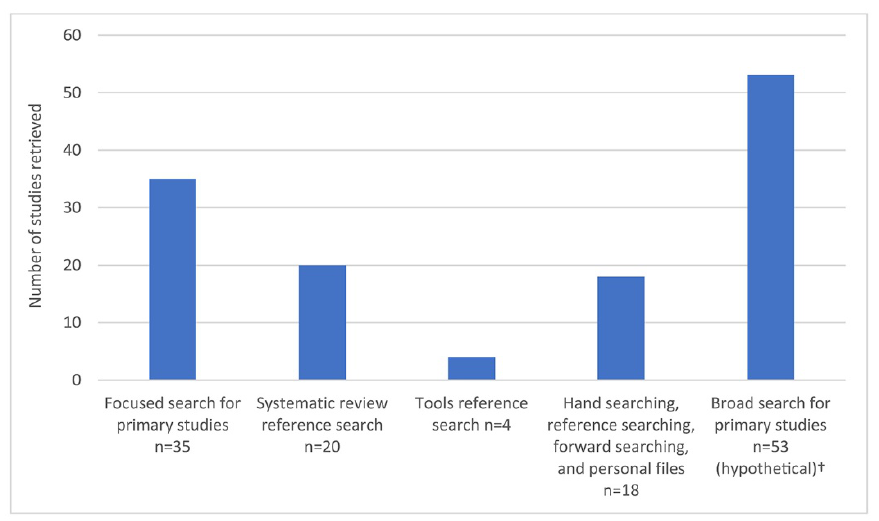
Figure 1 Visualization of studies indexed in Ovid MEDLINE (n=58)* retrieved by each search component used in Hayden et al.’s review [28], including the hypothetical broad electronic search